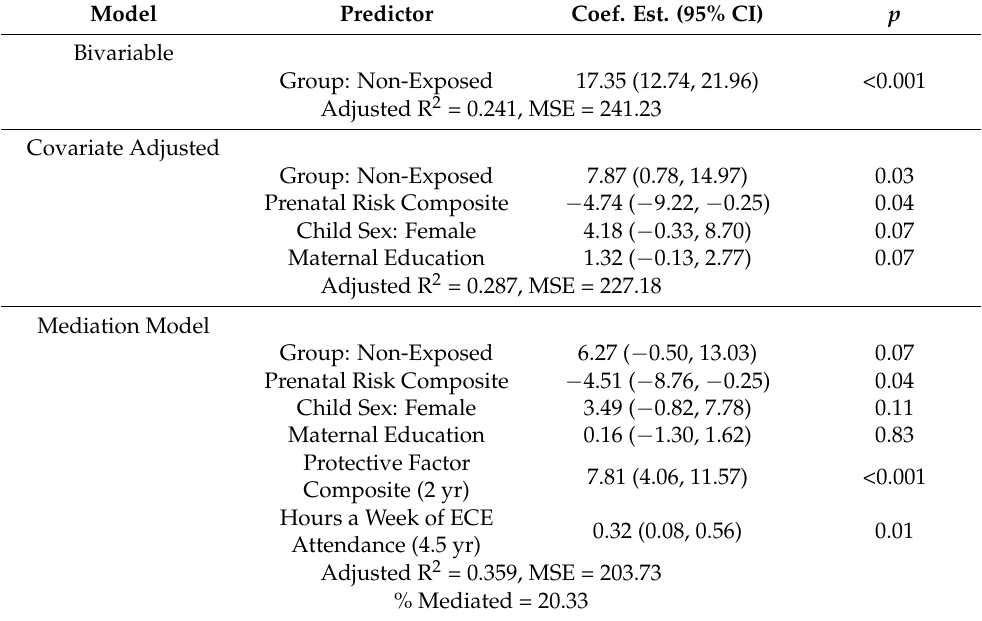
Table 4. Mediation analysis of prenatal opioid exposure and language development at age